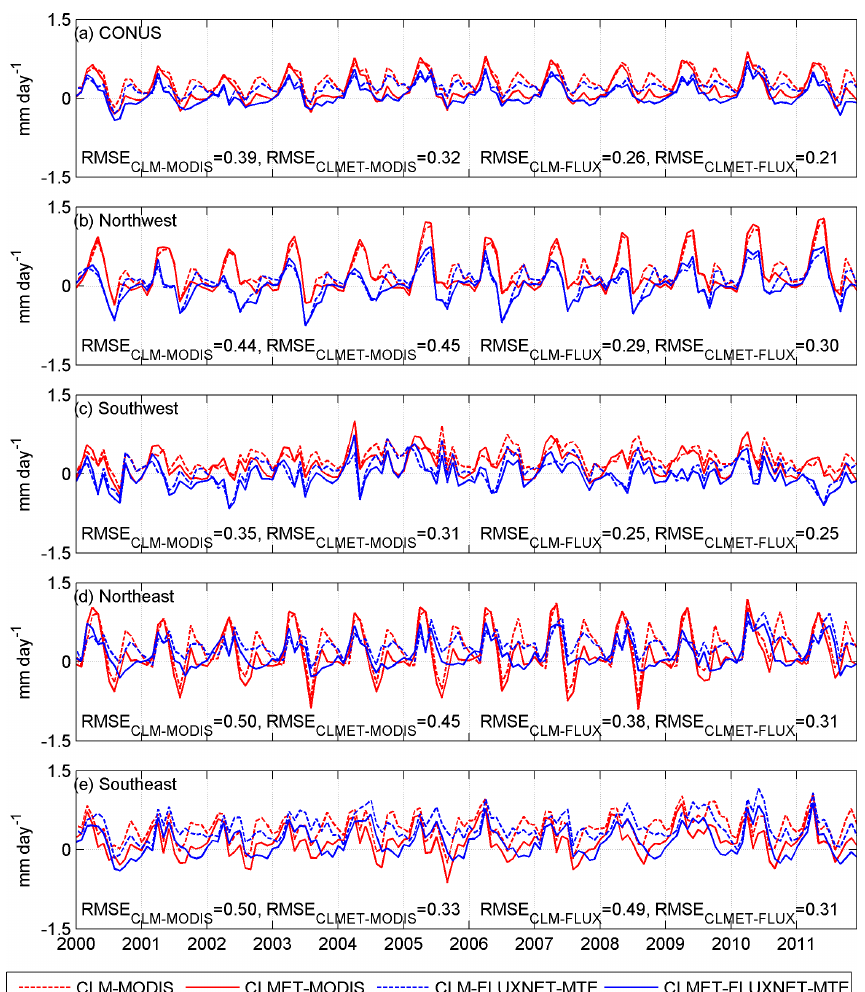
Figure 7. Time series of ET differences between model (CLM or CLMET) and reference data (MODIS or FLUXNET-MTE) over (a) the CONUS, (b) Northwest, (c) Southwest, (d) Northeast, and (e) Southeast during the period